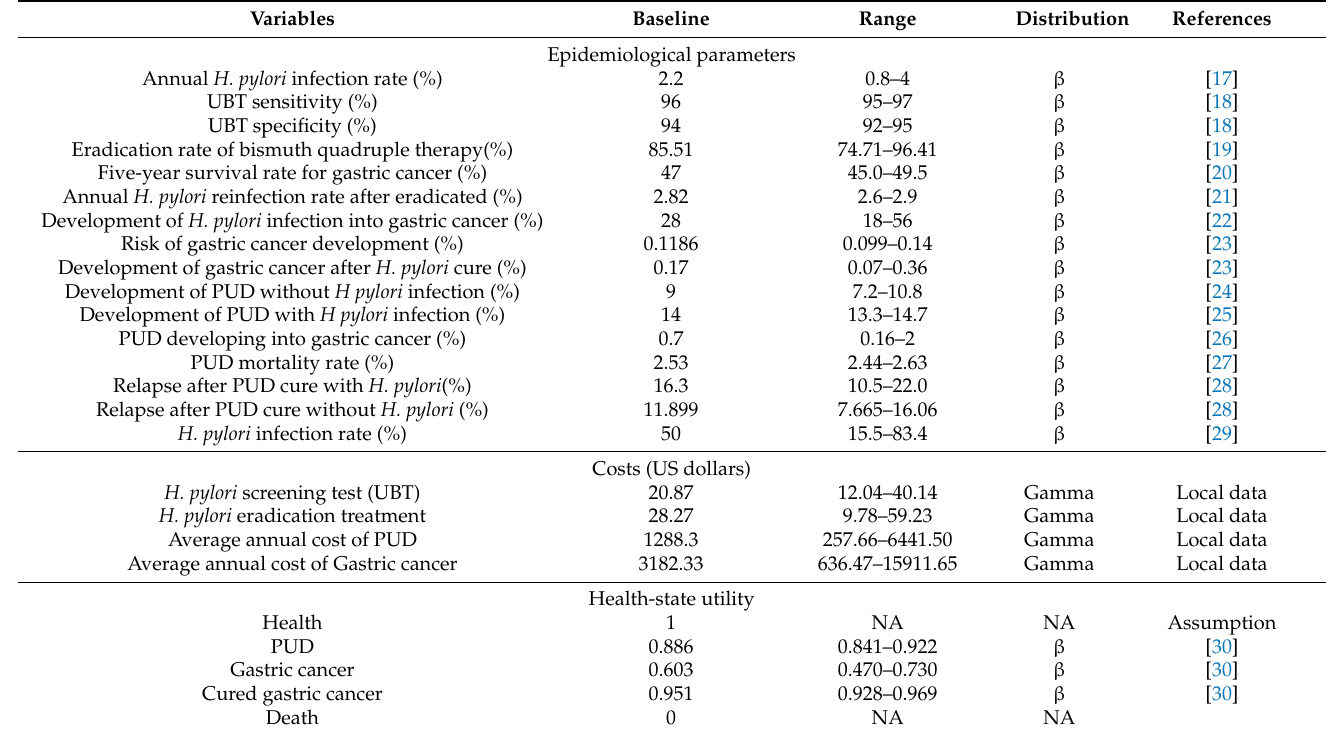
Table 1. Parameters in the model. PUD, peptic ulcer disease; UBT, urea breath test; NA, not applicable; Local data were obtained from reports published by the National Health and Family Planning Commission of China or the State Food and Drug Administration of